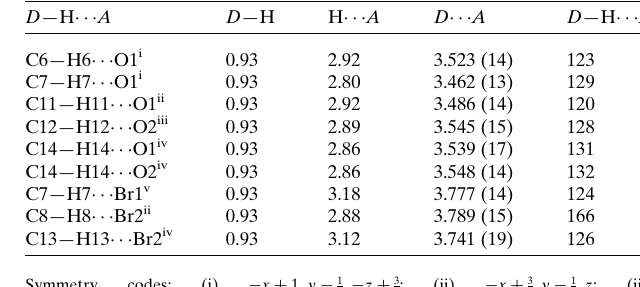
Table 1 Hydrogen-bond geometry (A˚ , (cid:5) ).